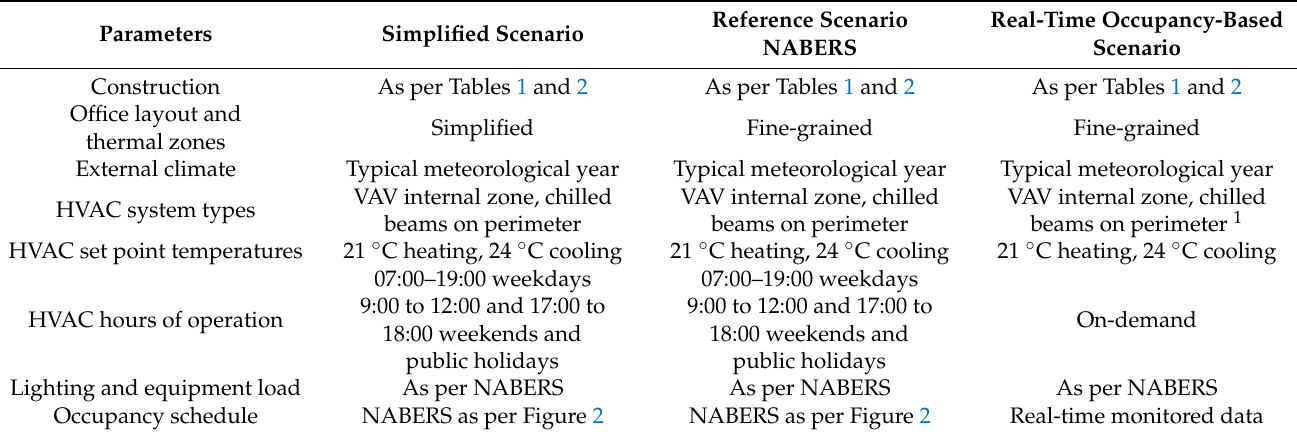
Table 3. Summary of the assumptions used in the